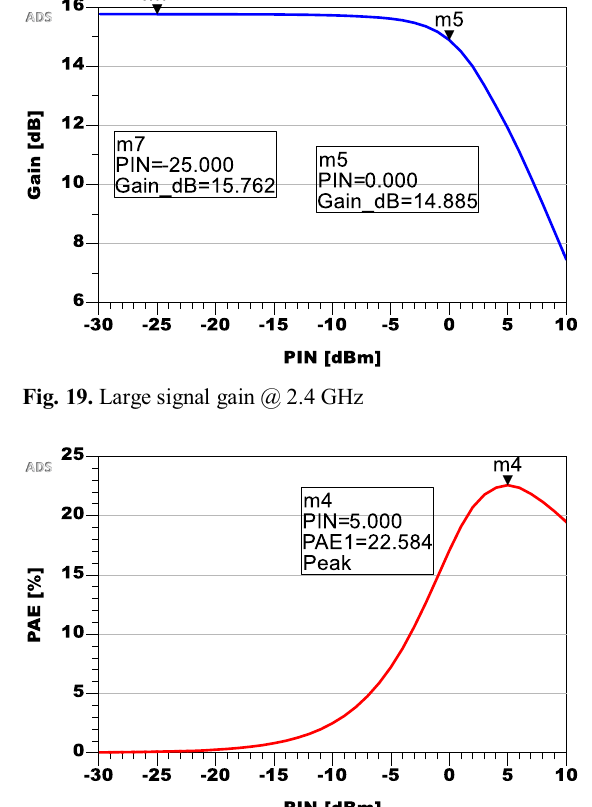
Fig. 17. Noise Figure response versus frequency